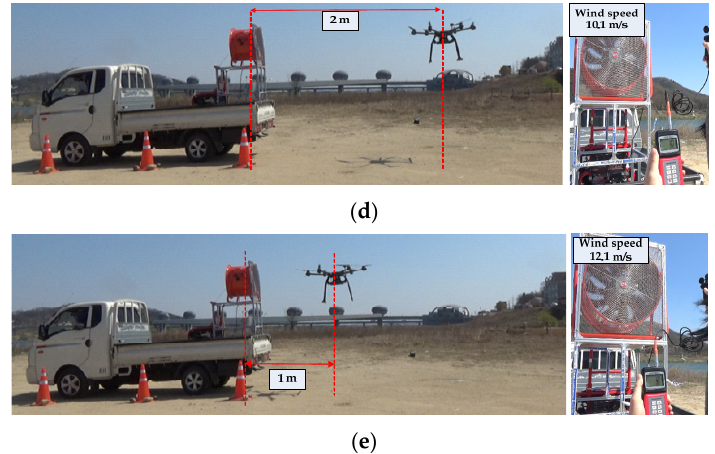
Figure 12. This is the wind resistance of the developed drone: ( a ) wind speed of 6.6 m/s at a distance of 8 m from the fan to the drone; ( b ) wind speed 7.7 m/s at a distance of 6 m from the fan to the drone; ( c ) wind speed 8.7 m/s at a distance 4 m from the fan to the drone; ( d ) wind speed 10.1 m/s at a distance 2 m from the fan to the drone; ( e ) wind speed 12.1 m/s at a distance 1 m from the fan to the drone.